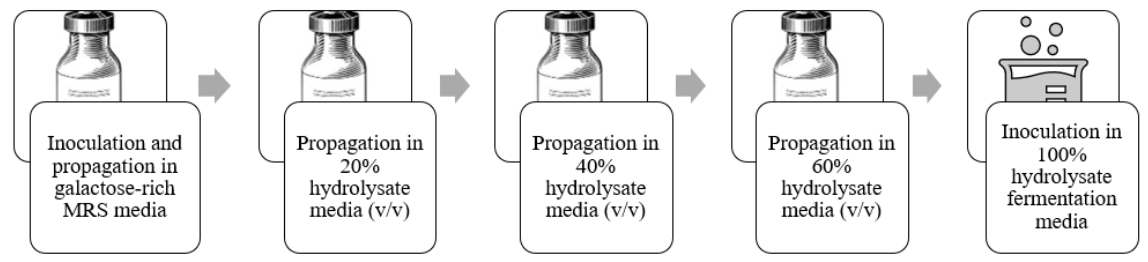
Figure 1. Acclimatization scheme for L. pentosus preparation in increasing ratios (% v / v ) of K. alvarezii hydrolysate in galactose rich MRS—Man–Rogosa–Sharpe medium.